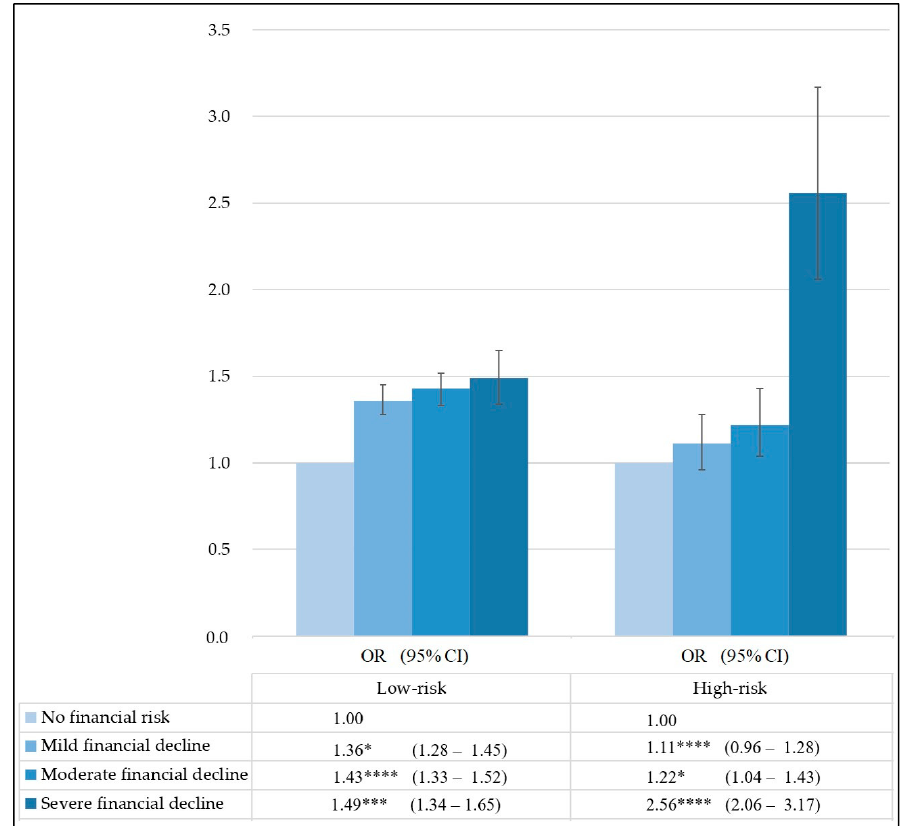
Figure 1. Results of household financial decline due to COVID-19 associated with smartphone dependency (The severity of smartphone dependency on household financial decline due to COVID-19 was analyzed by comparing the low-risk group and the high-risk group. Reference group: No financial decline. *: p ≤ 0.05, ***: p ≤ 0.001, ****: p ≤ 0.0001). Table 2. The results of subgroup analysis stratified by independent